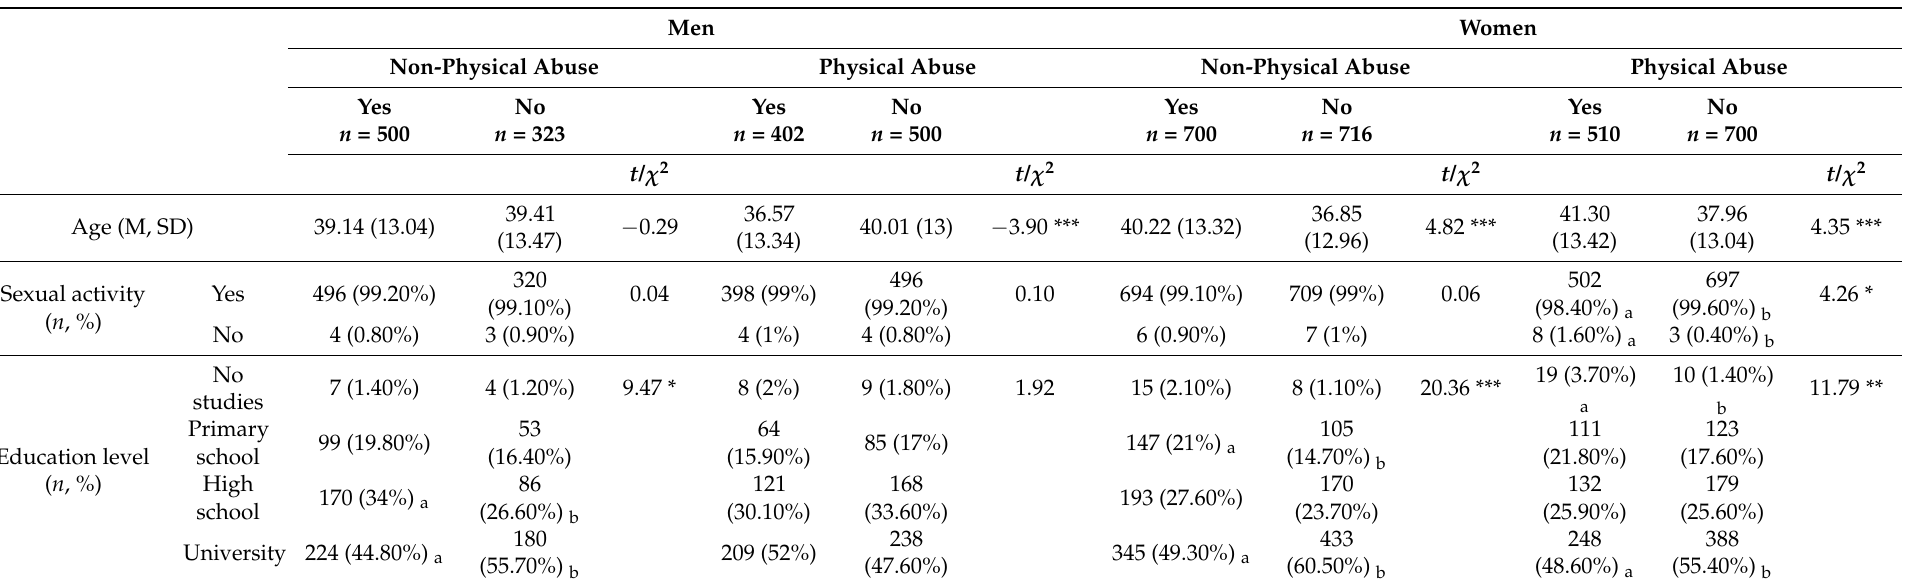
Table 1. Sociodemographic characteristics of men and women and differences between groups of non-physical and physical abuse. Men